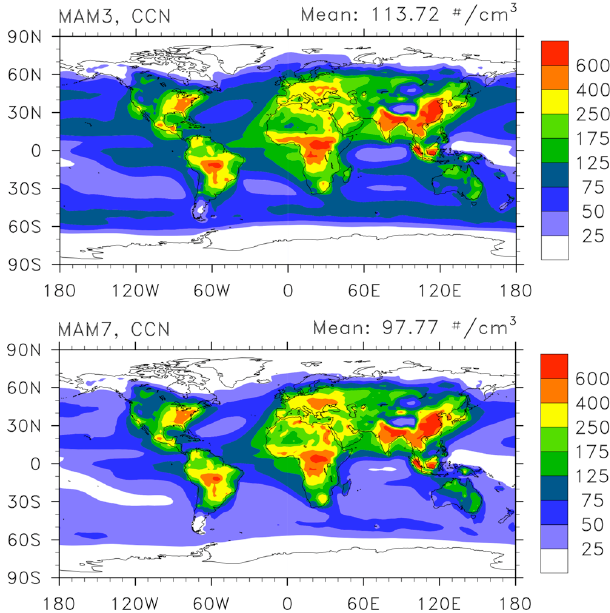
Fig. 7. Annual averaged global distribution of CCN number con- centration at 0.1% supersaturation at surface in MAM3 (upper) and MAM7